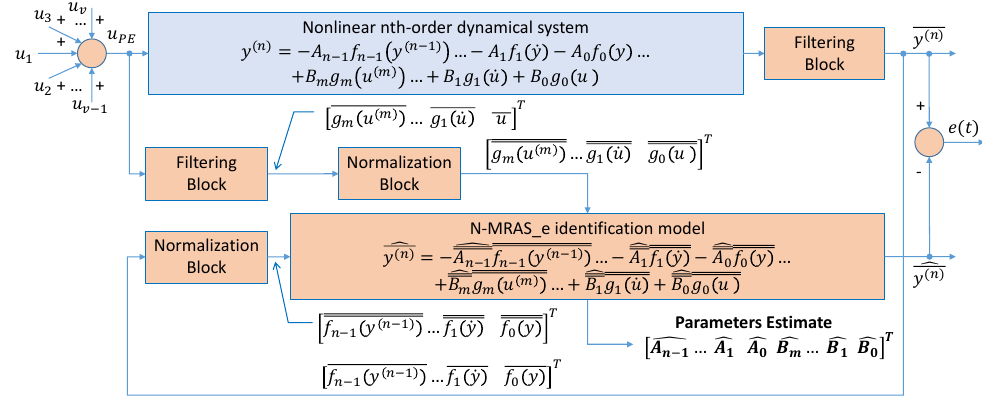
Figure 3. Block diagram of the proposed N-MRAS.